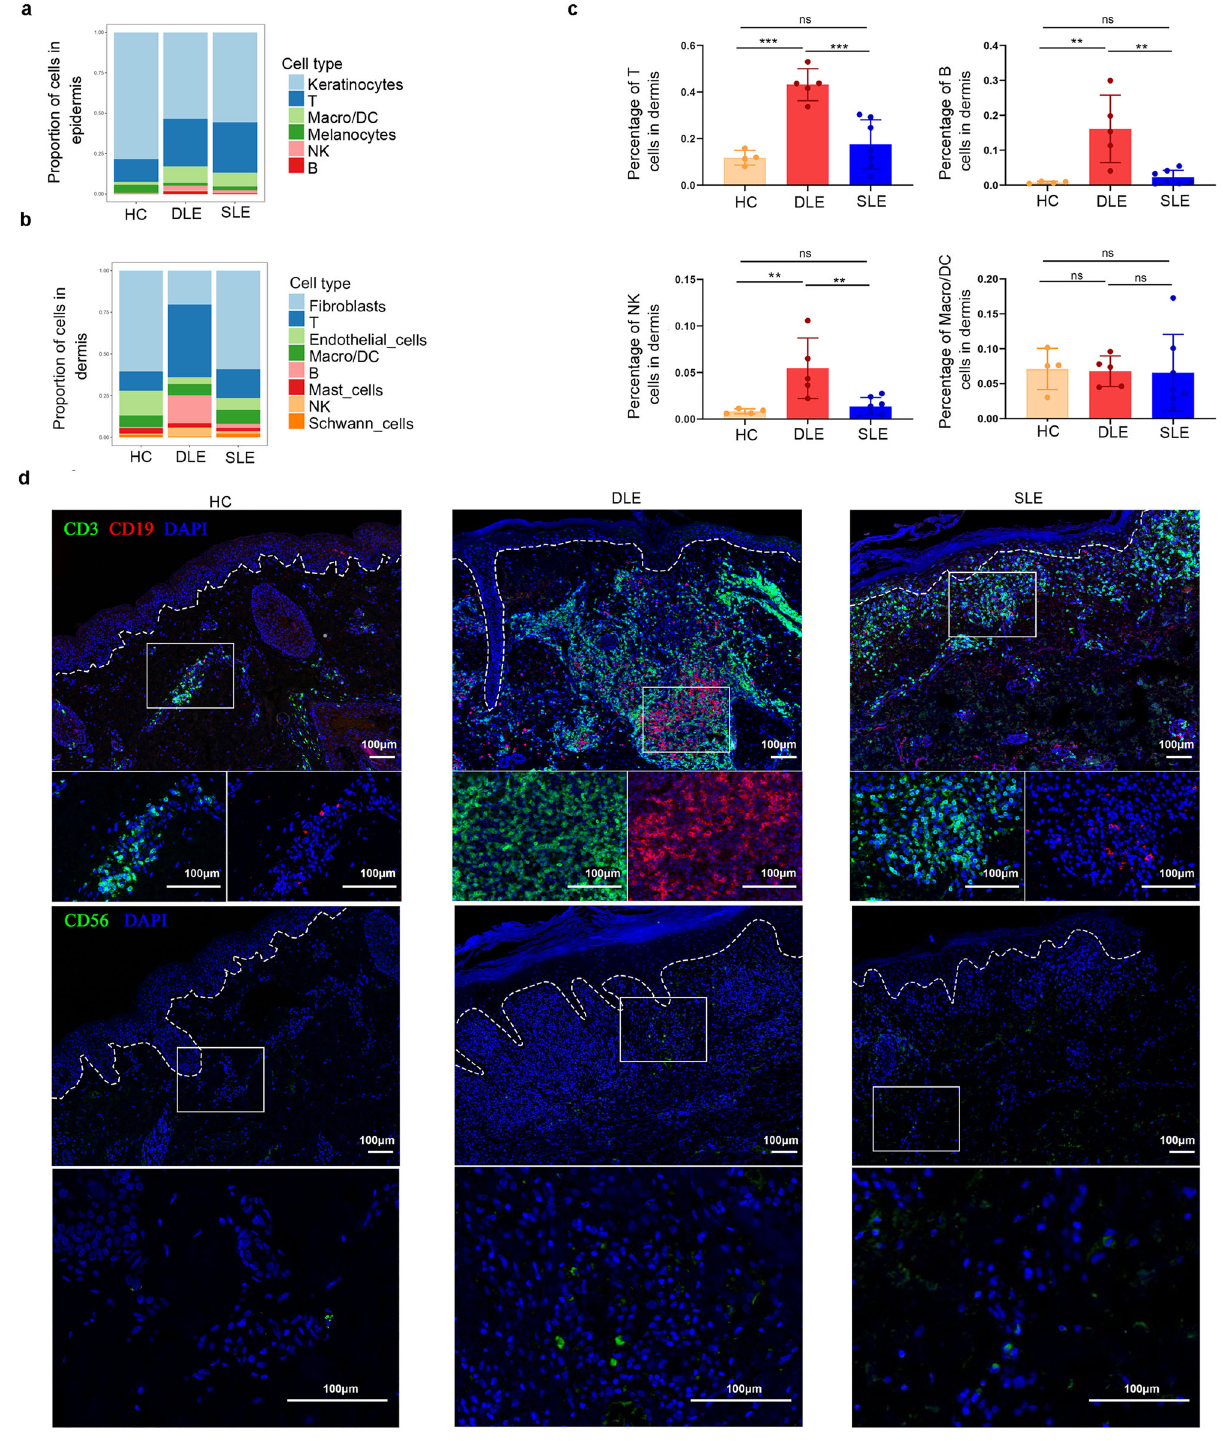
Fig. 2 | Distinct cell compositions of HC, DLE, and SLE. a , b Bar plots show the proportions of 6 celltypes in the epidermis ( a ) and 8 cell typesin the dermis( b )of biopsysamplesfromDLEandSLEpatients.Macro/DC:macrophages/dendriticcell. c Histogram plots comparing the proportions of the main immune cell types, including T cells, B cells, Macro/DCs and NK cells in dermis of HCs ( n =4), DLE patients( n =5),andSLEpatients ( n =7).ThehistogramsforHCsareshowninpink, histograms for DLE are in red and histograms for SLE are in blue. Data were pre- sentedasmean±SD,thePvalueswerecalculatedusingaone-wayANOVAtestwith Bonferroni ’ s multiple comparisons test. * P <0.05, ** P <0.01, *** P <0.001, ns: no